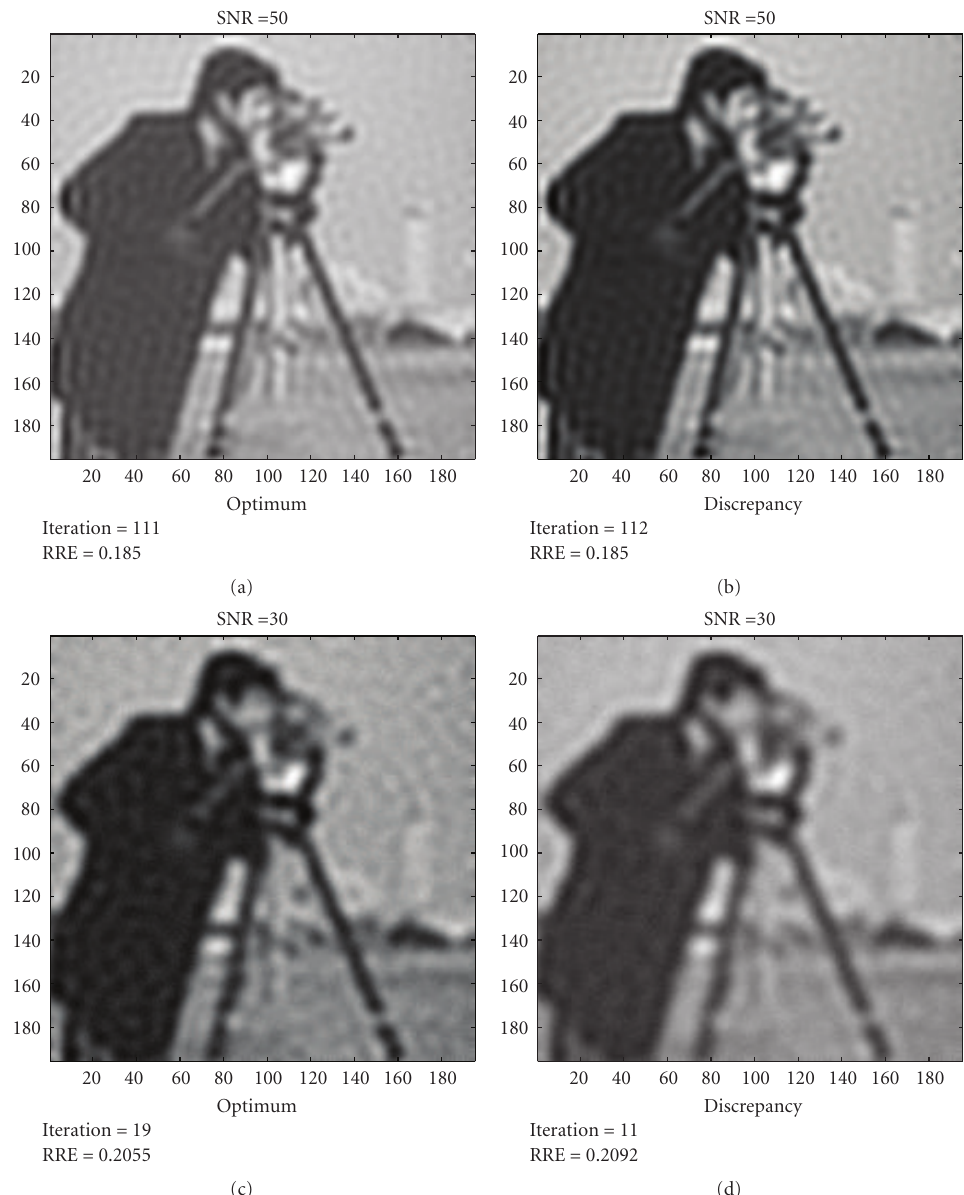
Figure 8: Discrepancy principle: images restored at the optimum value iteration and at which computed with the discrepancy principle.